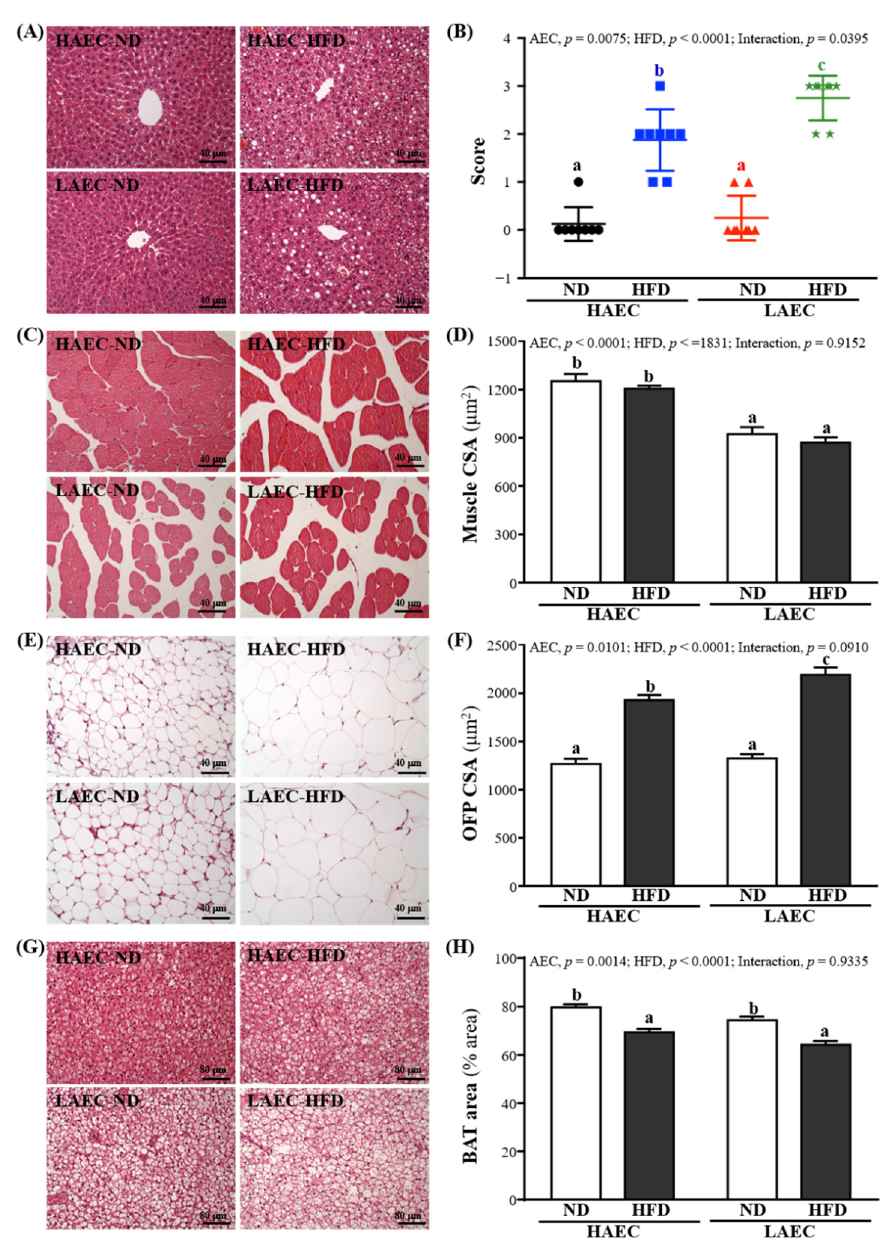
Figure 7. Effects of 12 weeks’ HFD feeding of HAEC or LAEC postpartum mice on histomorphologic features of the: ( A ) liver; ( B ) hepatocyte ballooning; ( C ) muscle; ( D ) muscle fiber CSA; ( E ) OFP; ( F ) OFP fiber CSA; ( G ) BAT; and ( H) BAT % area. Columns with different superscript letters (a, b, c) are significantly different between groups at p < 0.05 . Specimens were photographed under a light microscope with hematoxylin and eosin (H&E) stain. CSA, cross section area; OFP, ovarian fat pad; BAT, brown adipose tissue.